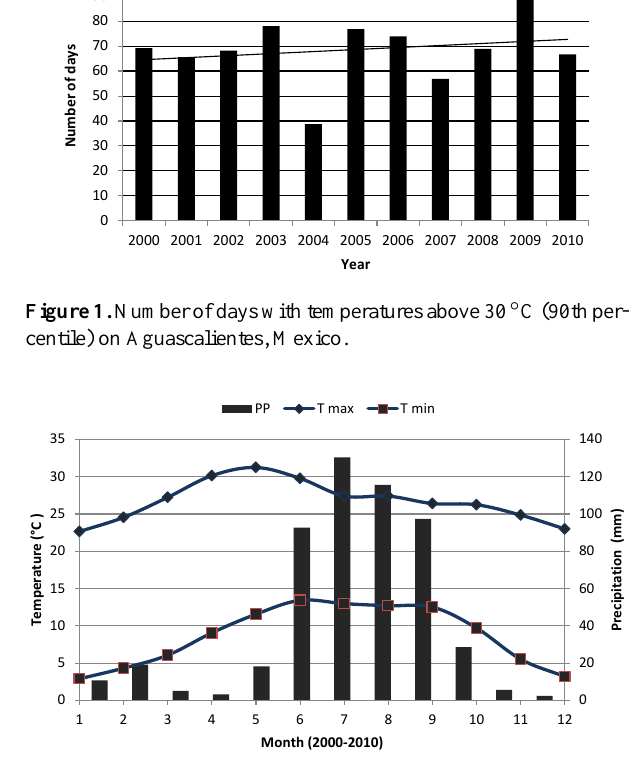
Figure 2. Climograph of Aguascalientes, Mexico for the